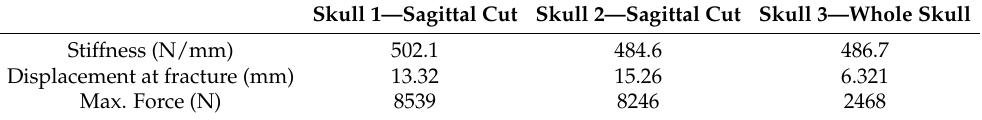
Table 3. Mechanical properties of specimens subjected to lateral compressive tests.